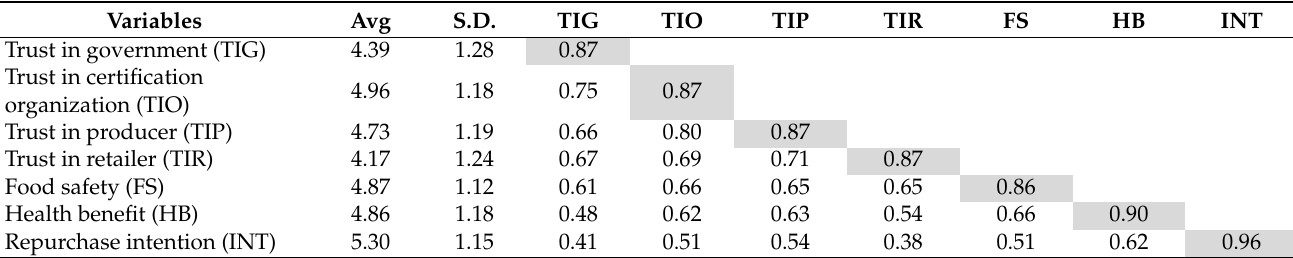
Table 2. Correlations among latent variables.